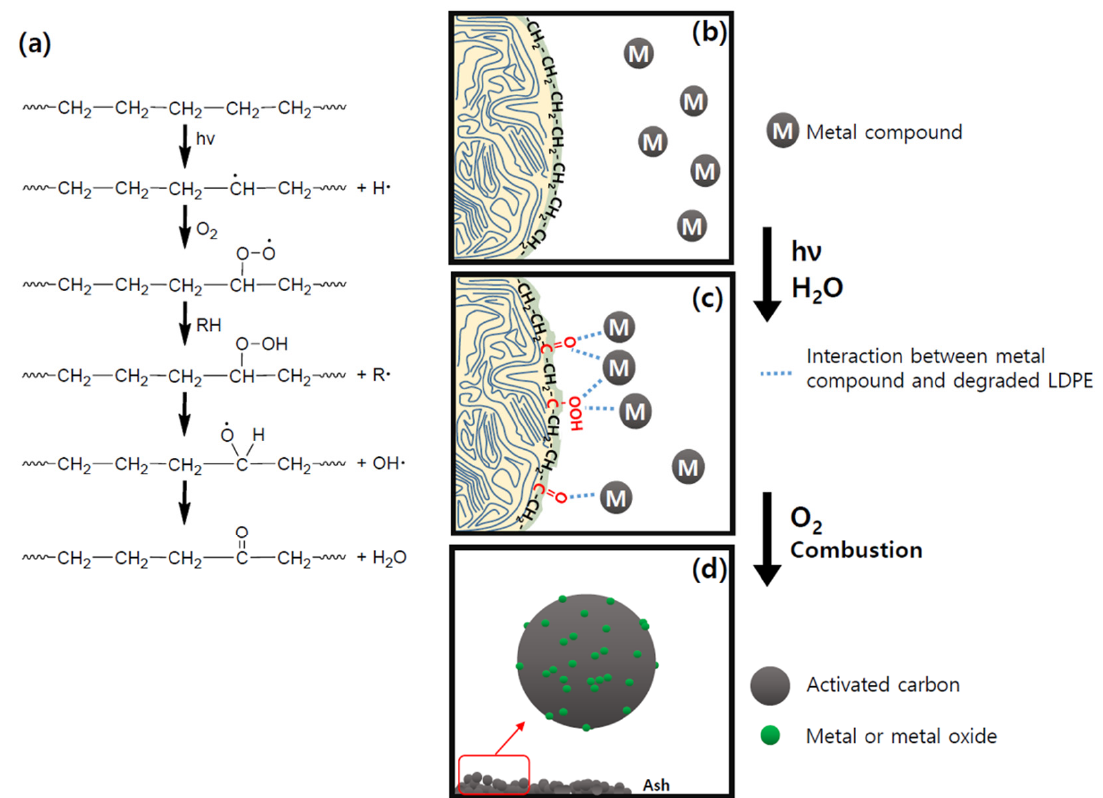
Figure 9. The process of combining LDPE and metal compound [62,63]: (a) Degradation mechanism of LDPE and schematic drawings of (b) non-degraded LDPE surface non-coordinated with metal compounds, (c) degraded LDPE surface coordinated with metal compounds, and (d) metal bounded carbon particles formed after calcination.